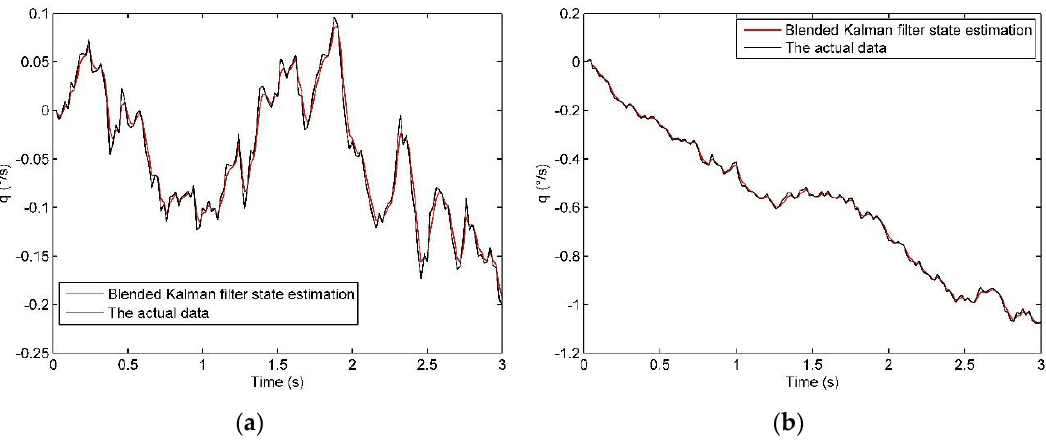
Figure 7. Type A fault vs. fault-free state estimation: ( a ) type A fault state estimation; ( b ) type A fault-free state estimation.